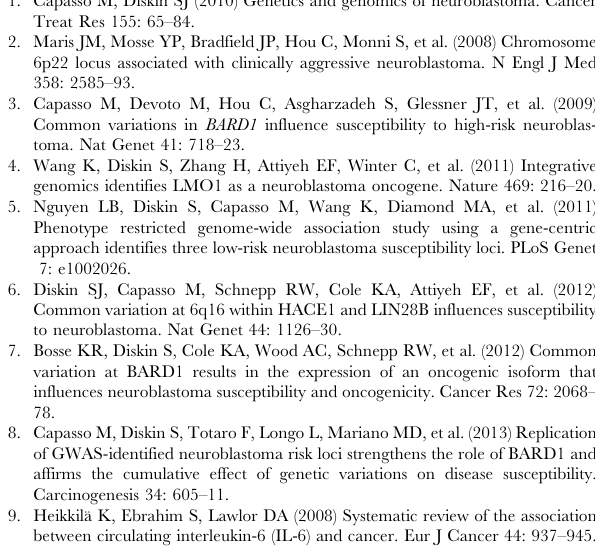
Table S1 Characteristics of NBL tumors. Table S2 Gene expression and clinical data of Versteeg dataset. Table S3 Gene expression and clinical data of Seeger